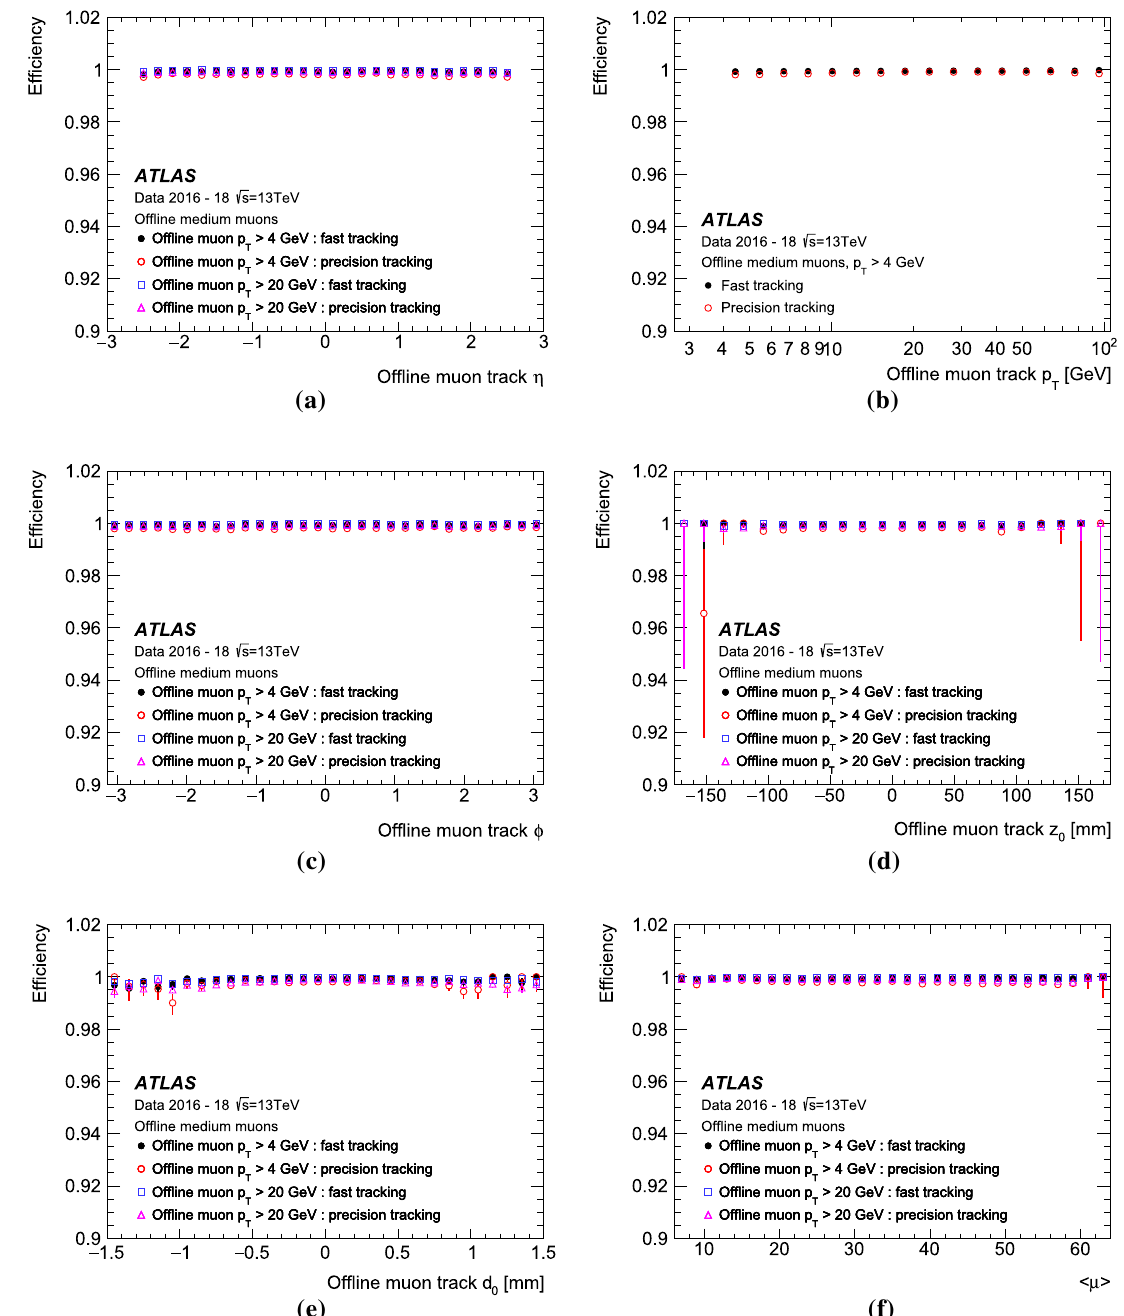
Fig. 17 The ID tracking efficiency for muons selected by the 4 GeV and 20 GeV muon support triggers, with respect to medium offline muon candidates with p T > 4 GeV or p T > 20 GeV. The efficiency is shown as a function of: a the offline reconstructed muon η , b the offline reconstructed muon p T , c the offline reconstructed muon φ , d